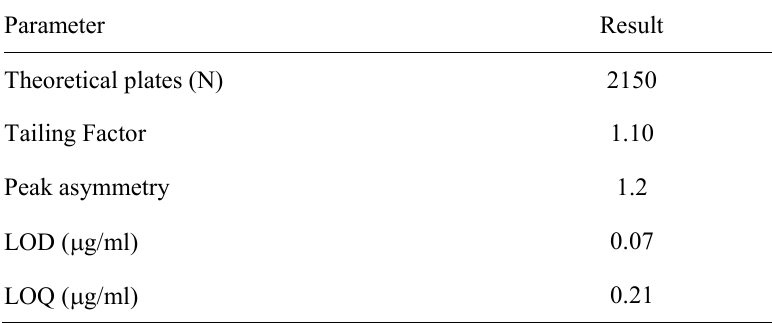
Table 3 : System suitability parameters.